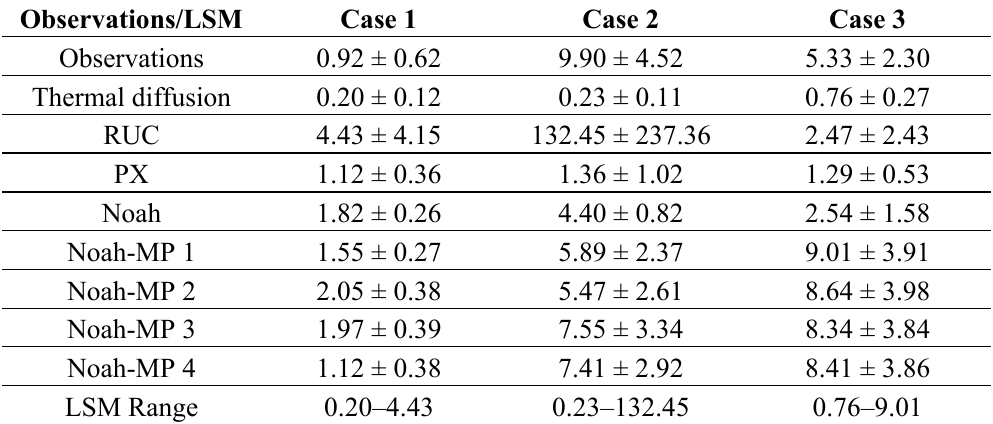
Table 3. Mean (± standard deviation) midday Bowen ratios by case period show differences across LSMs and